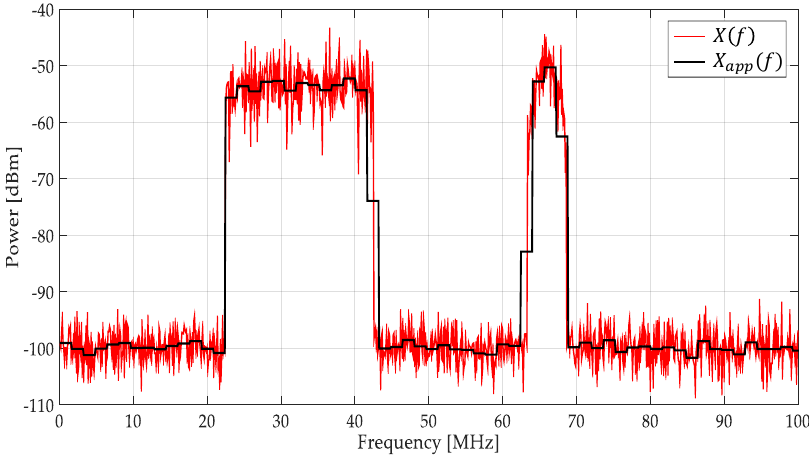
( ) X f ( f ) . Figure 4. The result of applying MRA to X